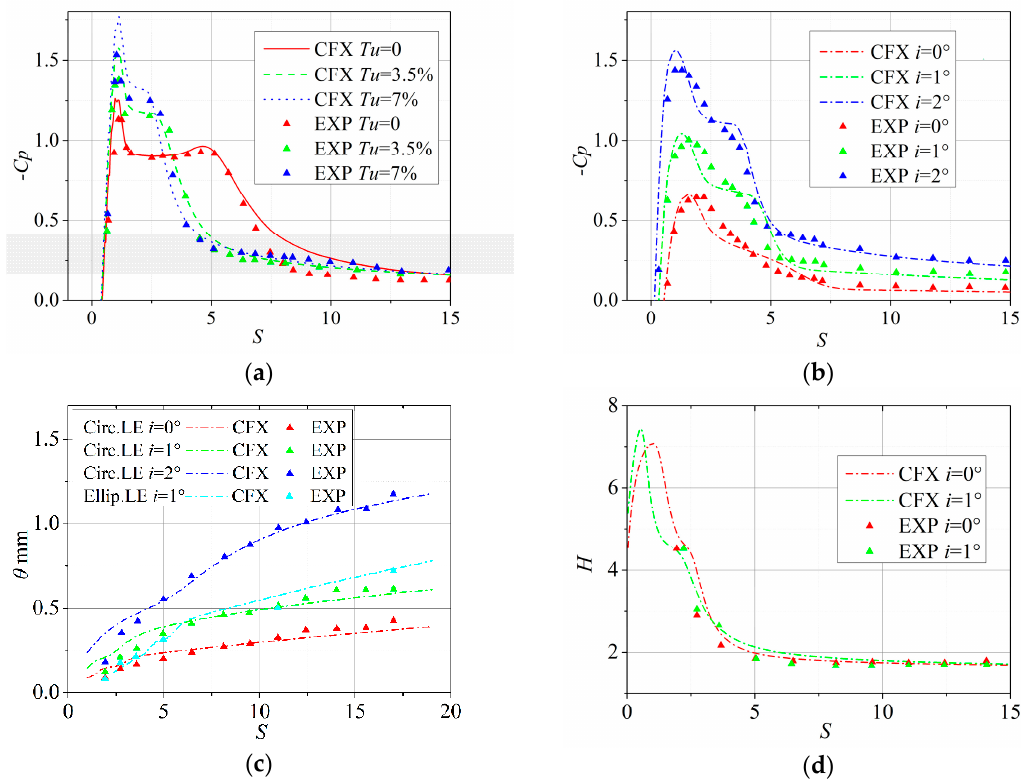
Figure 2. Verification of the simulation: ( a ) Cp of different turbulence values for Circ.LE; ( b ) Cp of different incidences for Ellip.LE at Tu =5%; ( c ) the momentum boundary layer thickness for Circ.LE and Ellip.LE at Tu = 5%; ( d ) Shape factor for Circ.LE at Tu = 5%.